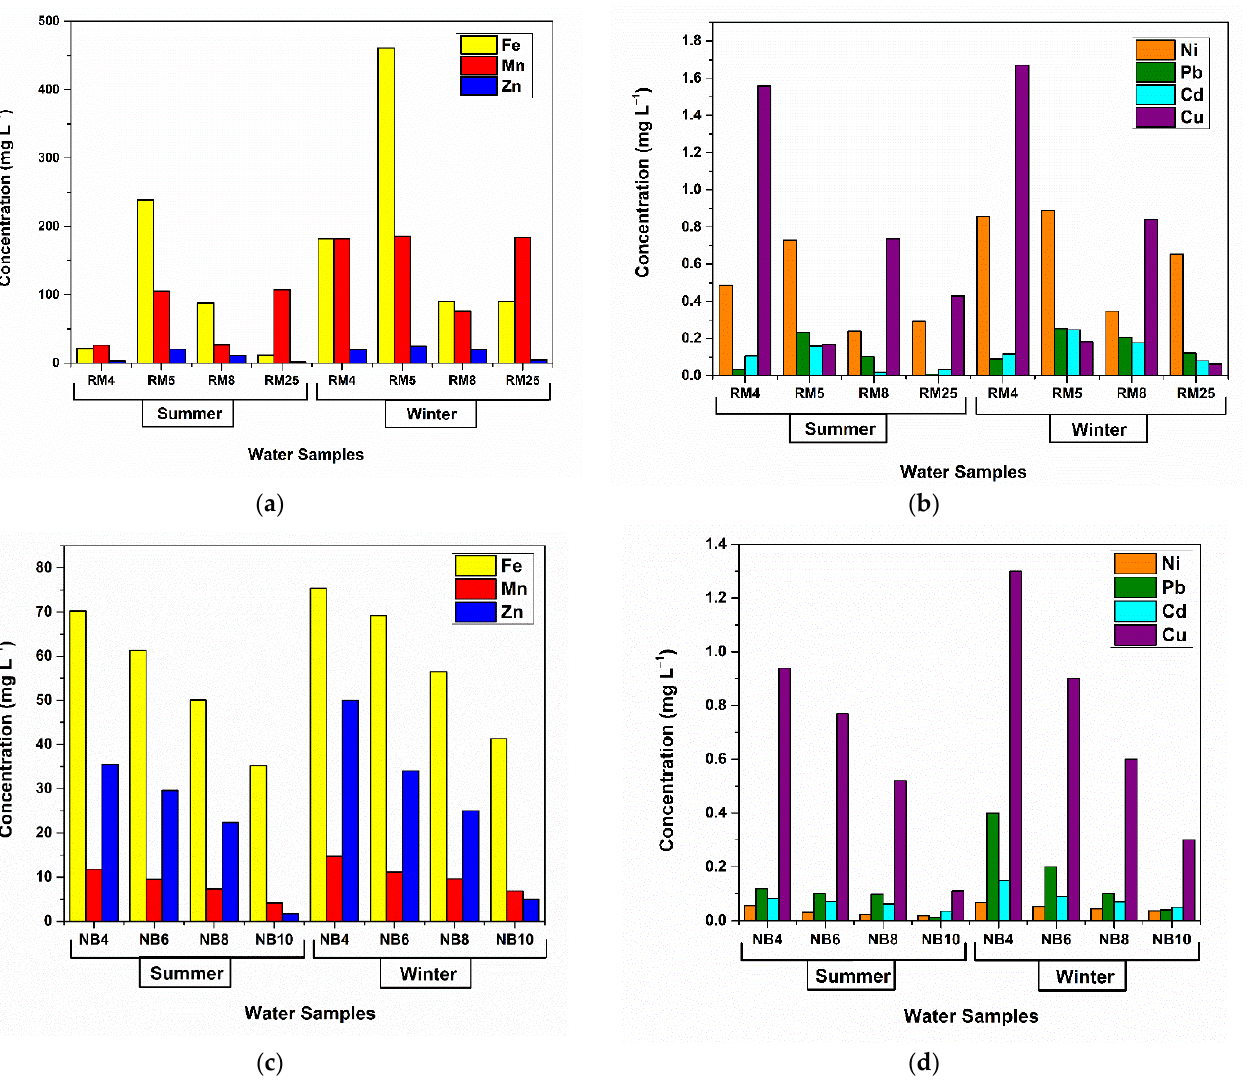
Figure 16. Heavy metals concentrations measured in water samples from ( a , b ) Ro ș ia Montan ă and ( c , d ) Nov ăț -Bor ș a mining areas, Romania.